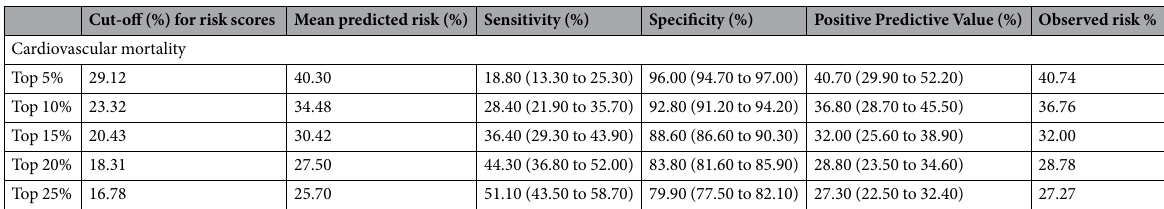
Table 4. Predicted risk of cardiovascular mortality the validation cohort based on various